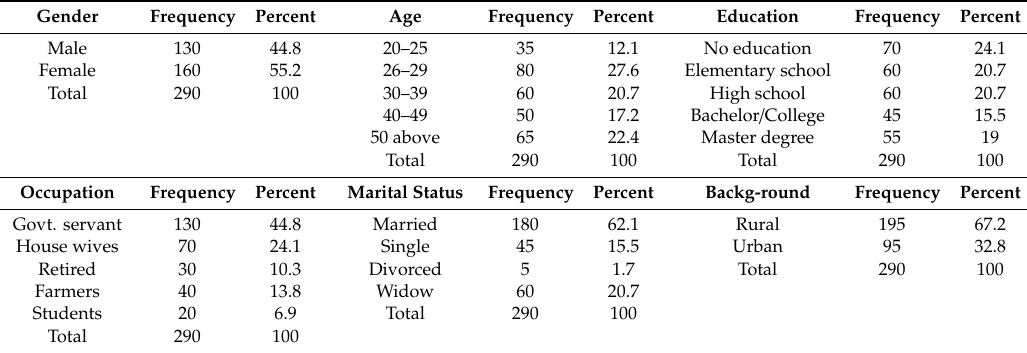
Table 1. Demographic